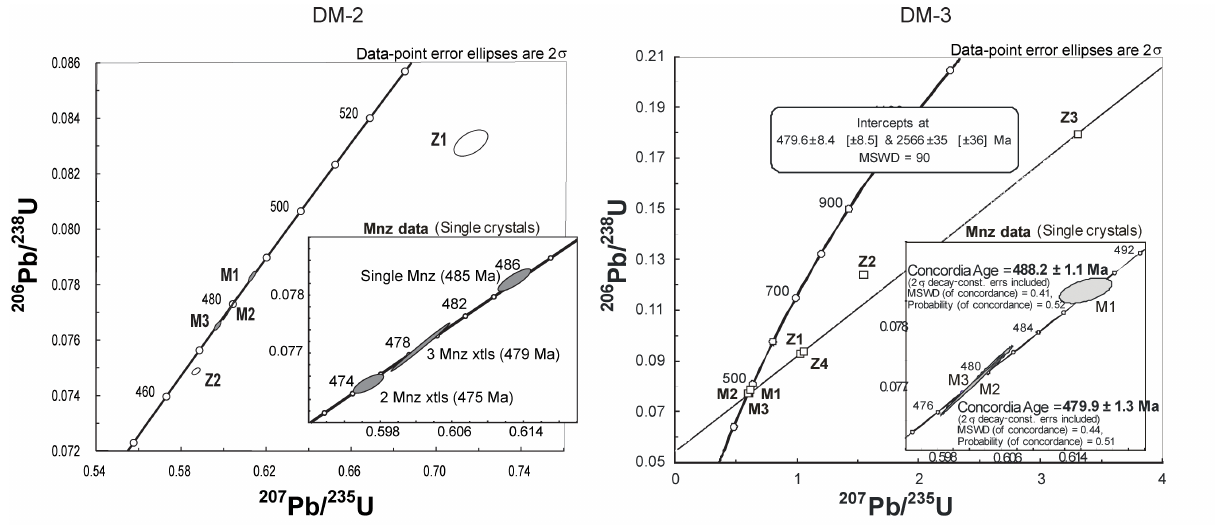
Figure 6. U–Pb CA-ID-TIMS data of the diorite dyke samples DM-2 and DM-3 (small white filled ellipses – zircon; grey ellipses – monazite). Locations are in Fig. 2a.